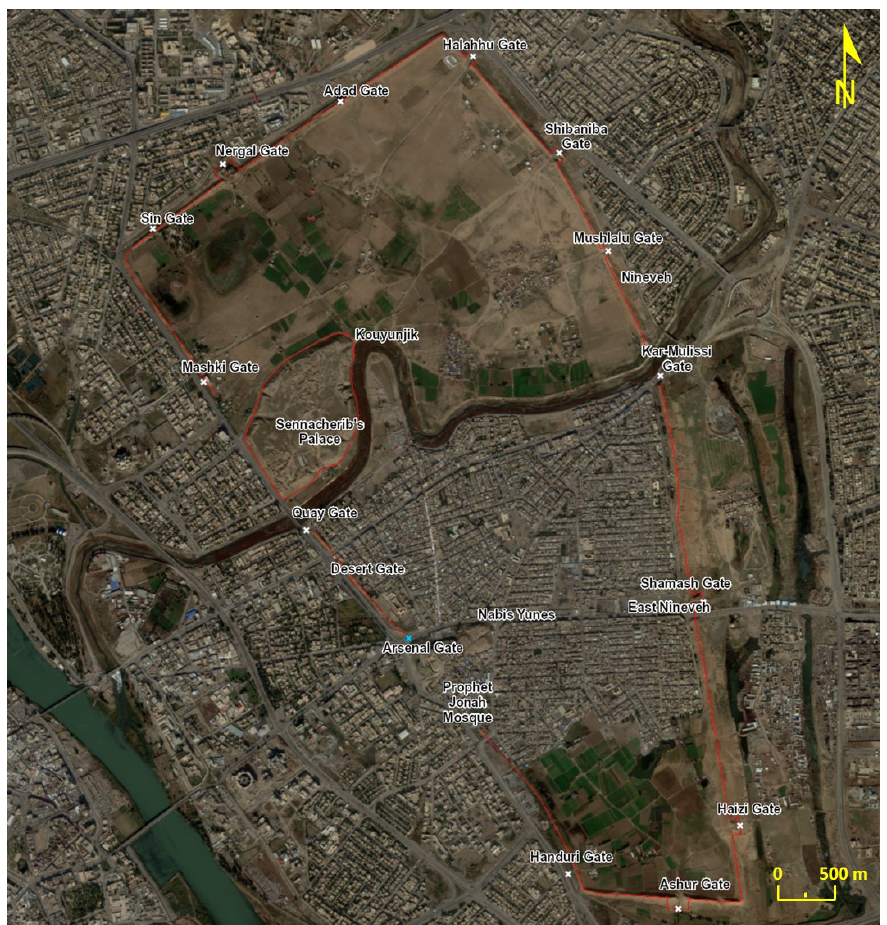
Figure 2. Overview of the walls and gates of Nineveh, with Nebi Yunus and Kouyunjik mounds location—WorldView-2, 13 November 2013 c (cid:13)